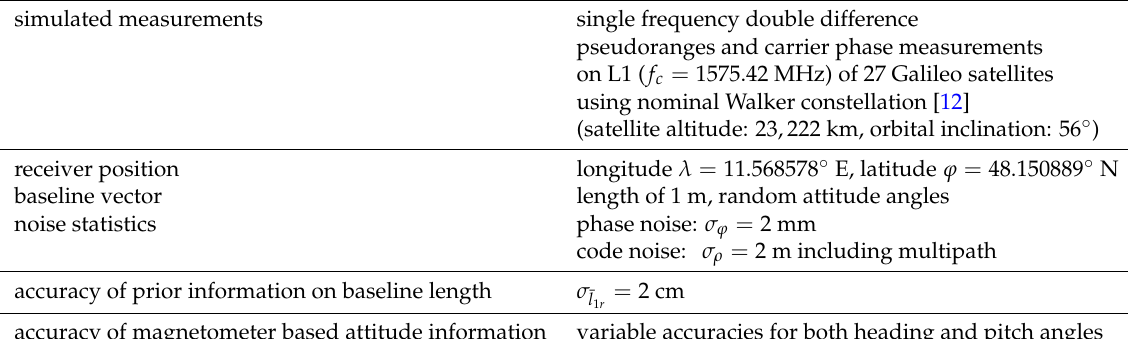
Table 1. Simulated Galileo double difference measurements.